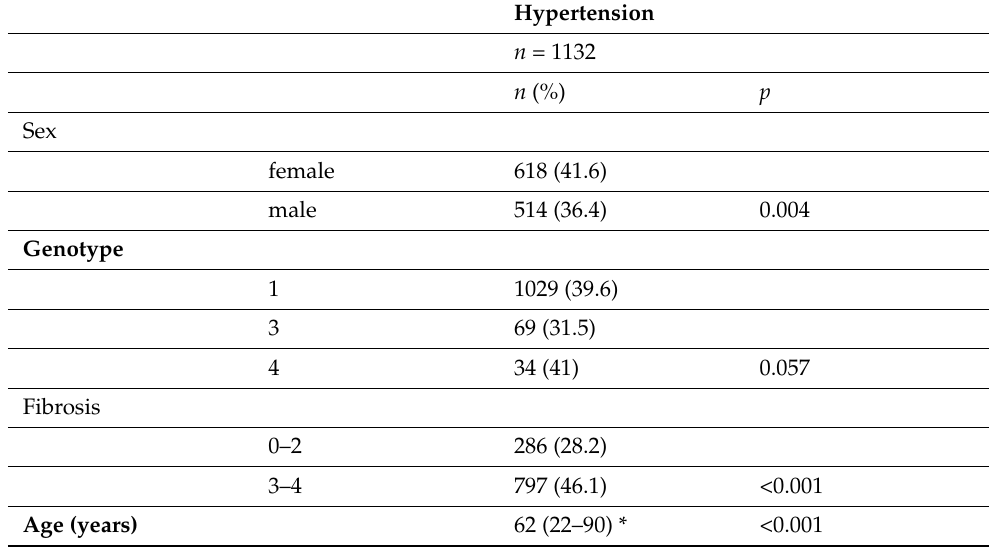
Table 2. The characteristics of patients—hypertension—in relation to all the study